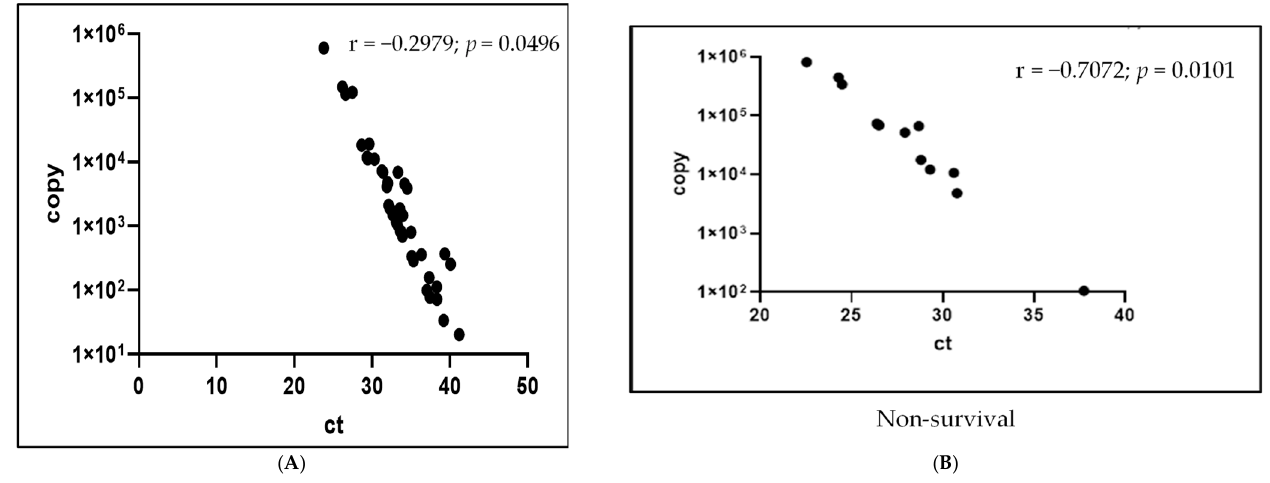
Figure 2. ( A ) Correlation diagram between the Ct value and the SFTS viral copy number of the survival group. ( B ) Correlation diagram between the Ct value and the SFTS viral copy number of the non-survival group.